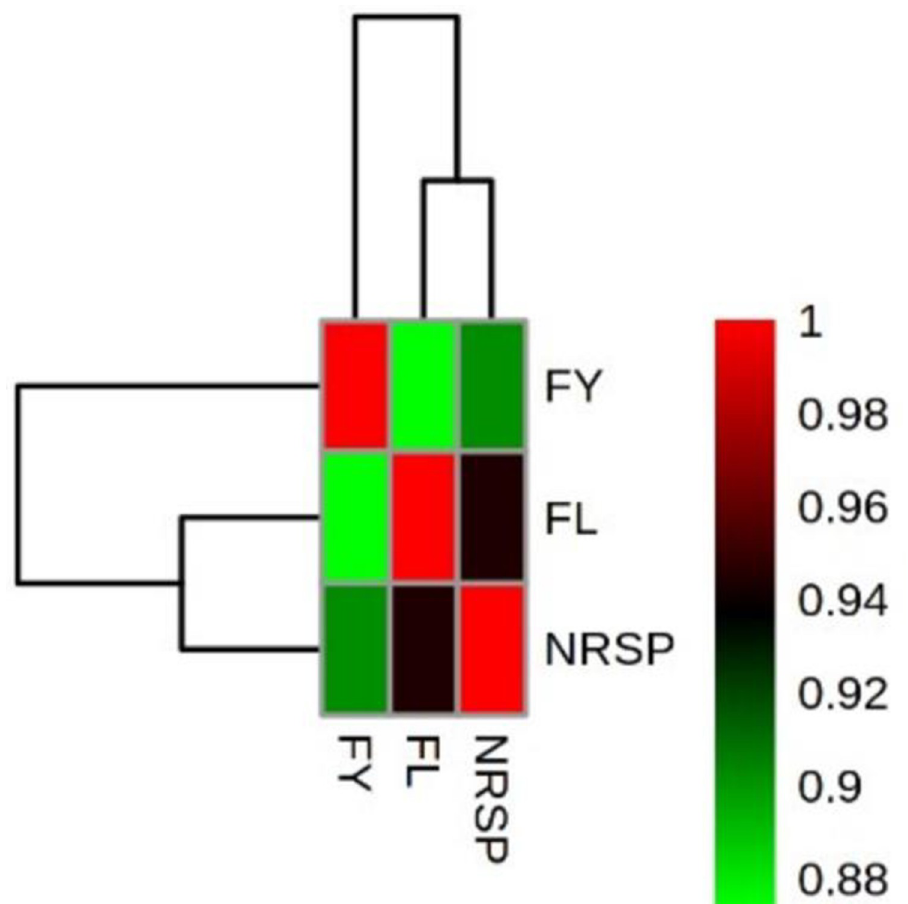
Fig 2. Heat map correlation among the measured characters of banana. (FY: fruit yield, FL: fruit length, and NRSP: number of rows per spike). The color scales represent the values were correlation coefficients from 0.88 (green) to 1 (red).